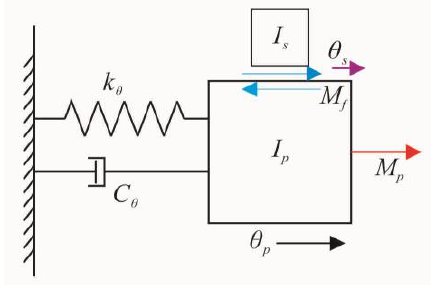
Figure 3. Simplified model of the prototype motor.